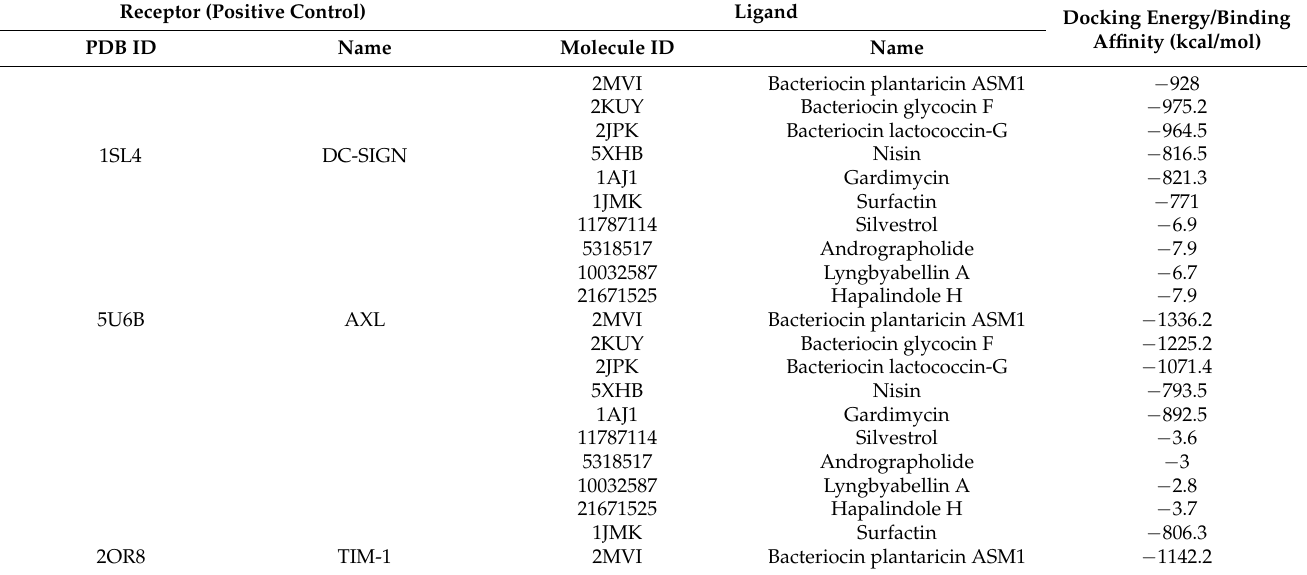
Table 2. Molecular docking data of cellular virus receptors with selected